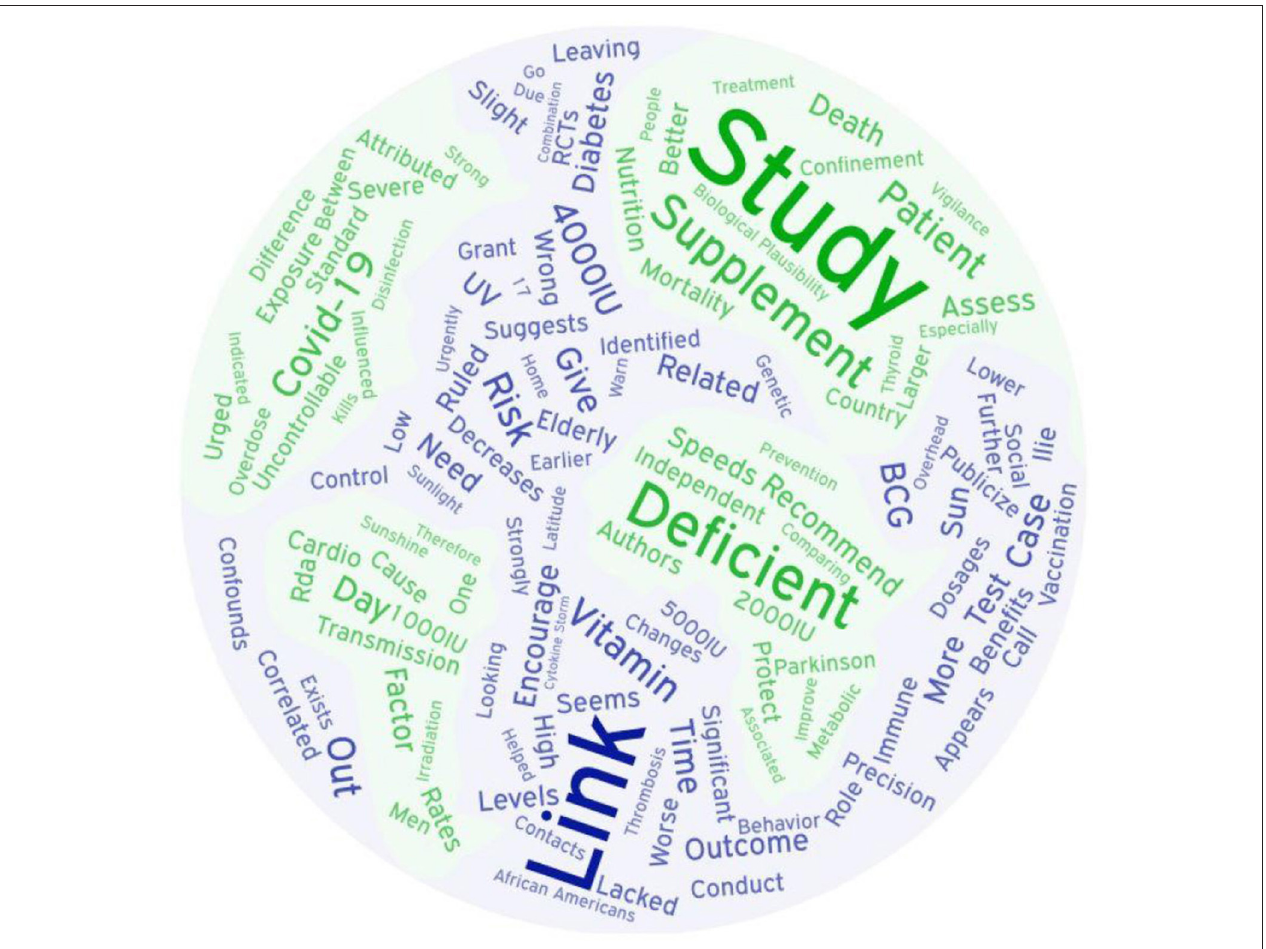
FIGURE 9 | Word Cloud of recommendations from authors of 47